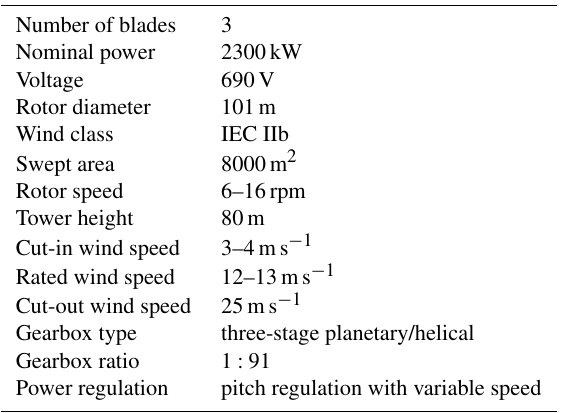
Table 3. The main technological features of the type of WT in the wind park